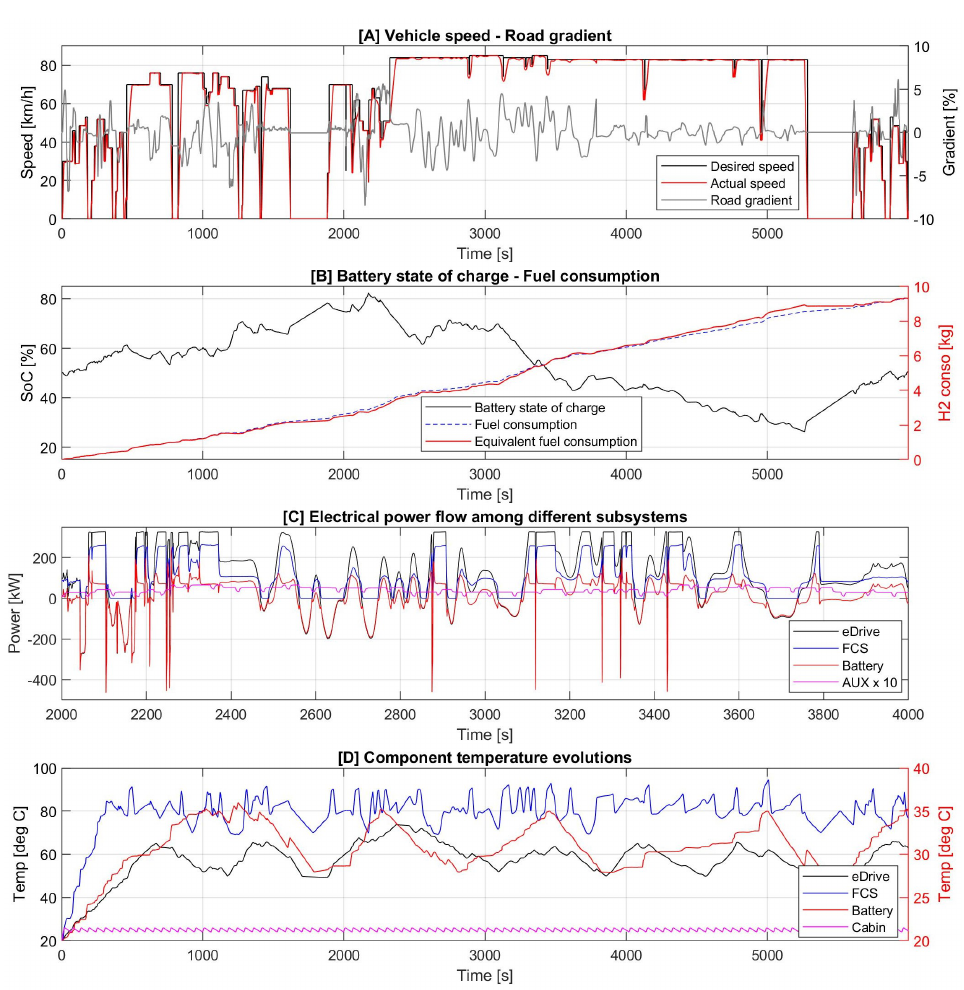
Figure 5. Simulation results for HD FCEV truck running on VECTO Regional delivery cycle: ( A ) dis- tance based desired and actual vehicle speed, road gradient; ( B ) battery state of charge, cumulative and equivalent H 2 fuel consumption; ( C ) electrical power flow among FCS, HV battery, eDrive and auxiliary load governed by the ECMS strategy; and ( D ) component temperature